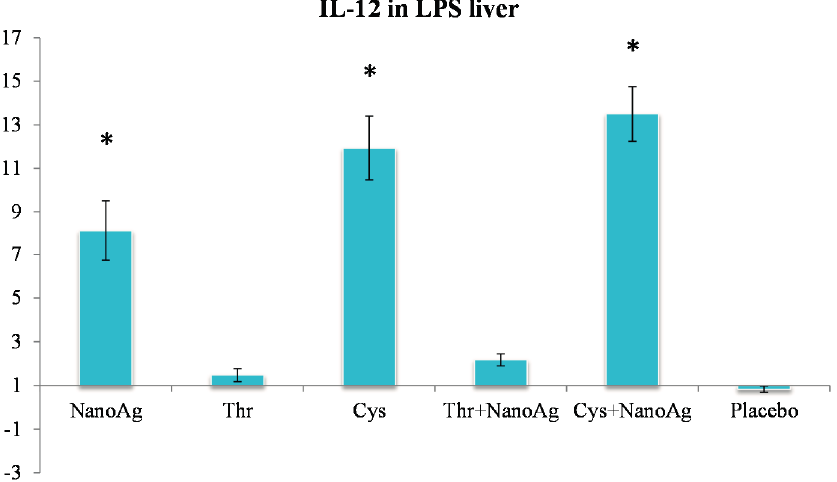
Figure 4. Relative fold expression level of interleukin-12 ( IL-12 ) gene in hepatic tissues of LPS induced in ovo NanoAg and/or amino acid injected embryos. Expression of uninjected control embryo is taken as 1.0. * indicates significant expression at the level of 95% ( p <